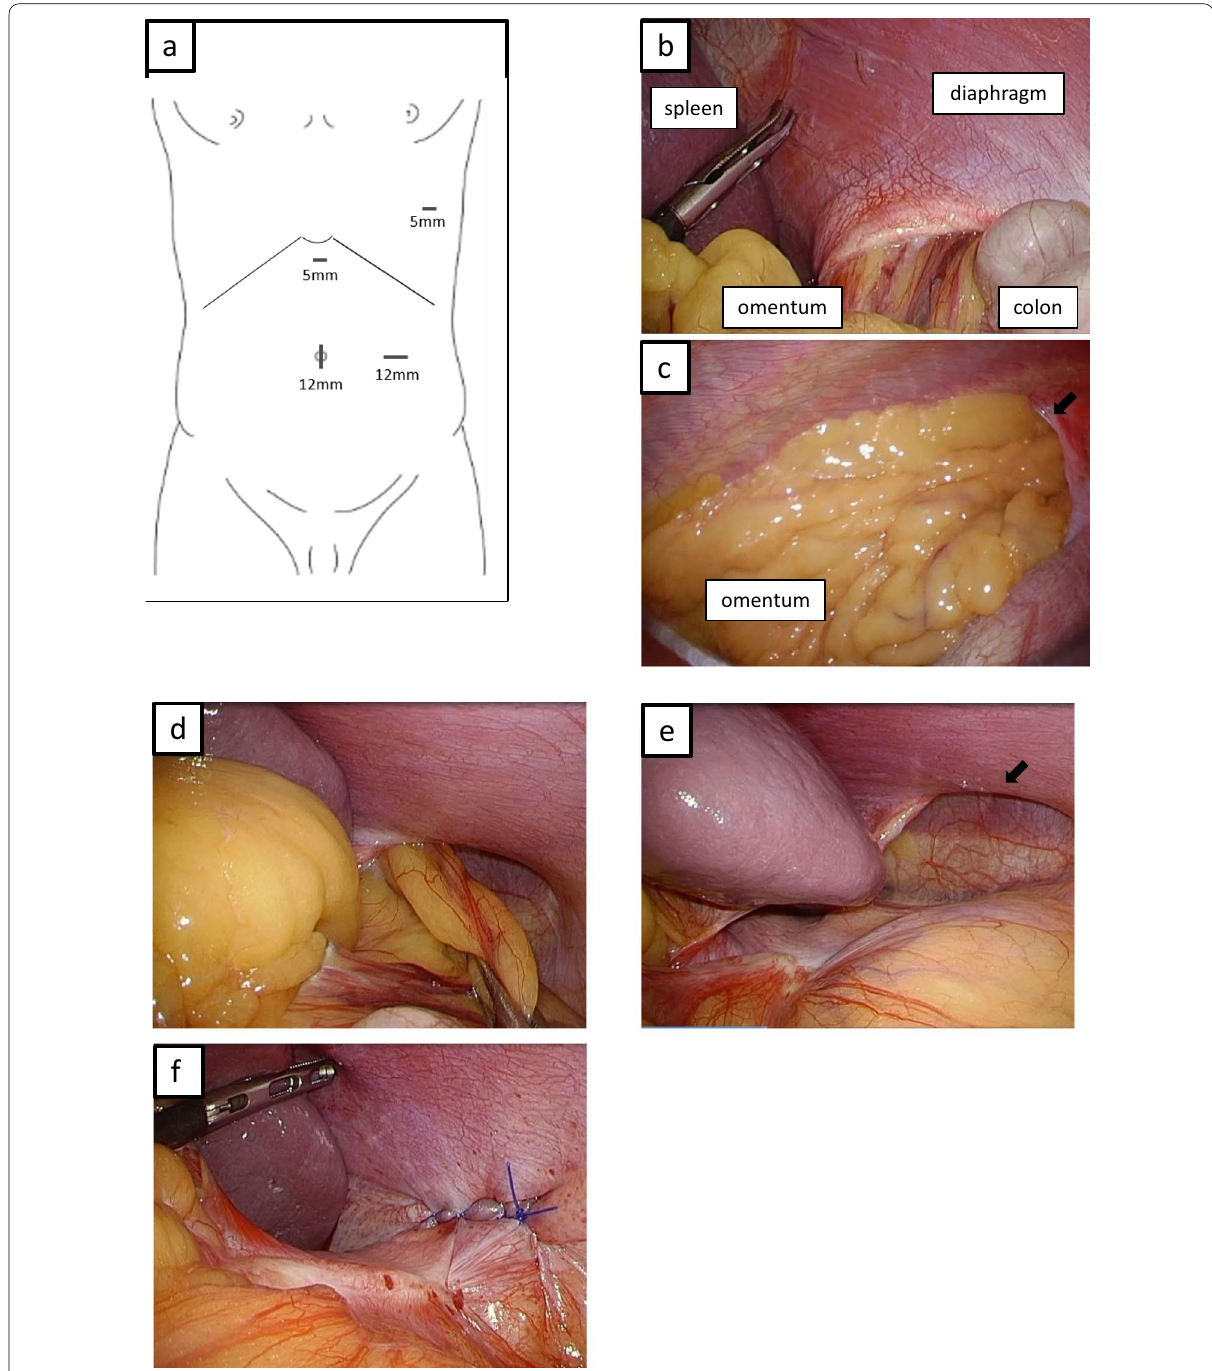
Fig. 2 Intraoperative findings. a Ports placement. b Laparoscopy showing the orifice at the posterolateral left diaphragm with herniation of the omentum. c Thoracoscopy showing the hernial orifice at the posterolateral portion of the left diaphragm (arrow) and the omentum prolapsed into the thoracic cavity. d Drawn out omentum into the abdominal cavity. e A 4